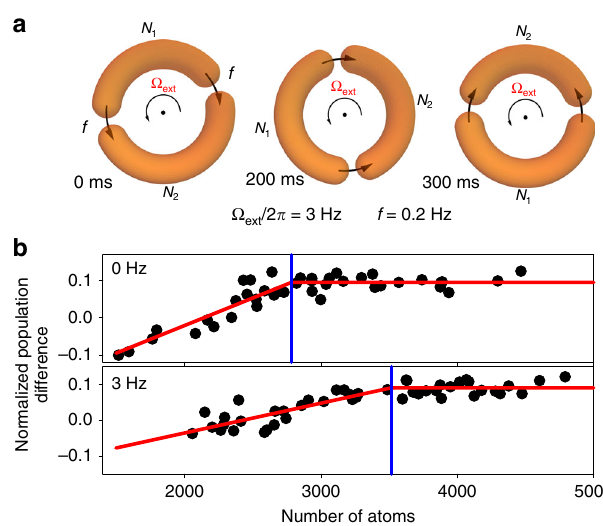
Fig. 2 Movement of Josephson junctions for the measurement of the critical atom number. a Movement of Josephson junctions during the experimental observation of quantum interference. The total duration of the junction movement used to create a bias current was 300 ms with a 3 Hz rotation frequency ( Ω ext /2 π ) and a 0.2 Hz frequency for the bias current generation ( f ). b Variation of z as a function of the number of atoms for two different rotation frequencies with fi tting to determine the critical atom number for the atomtronic SQUID of radius 4.82 µ m. The red line shows the best fi t with a piecewise function of a constant and a straight line with a slope with the blue line indicating the transition point and critical atom